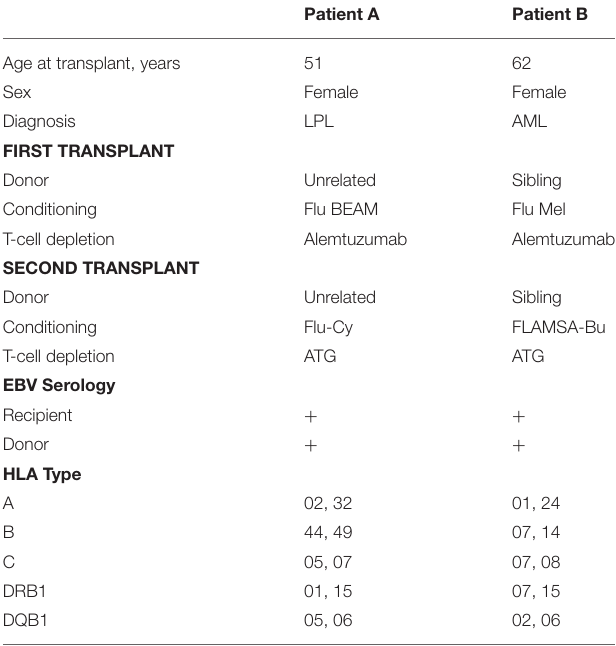
TABLE 1 | Patient